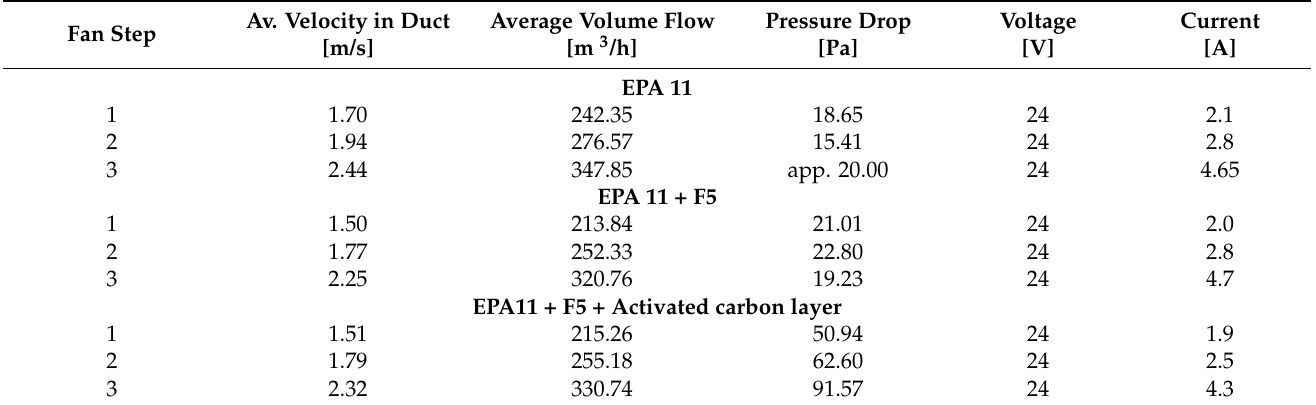
Table 1. Characteristics of examined three-stage